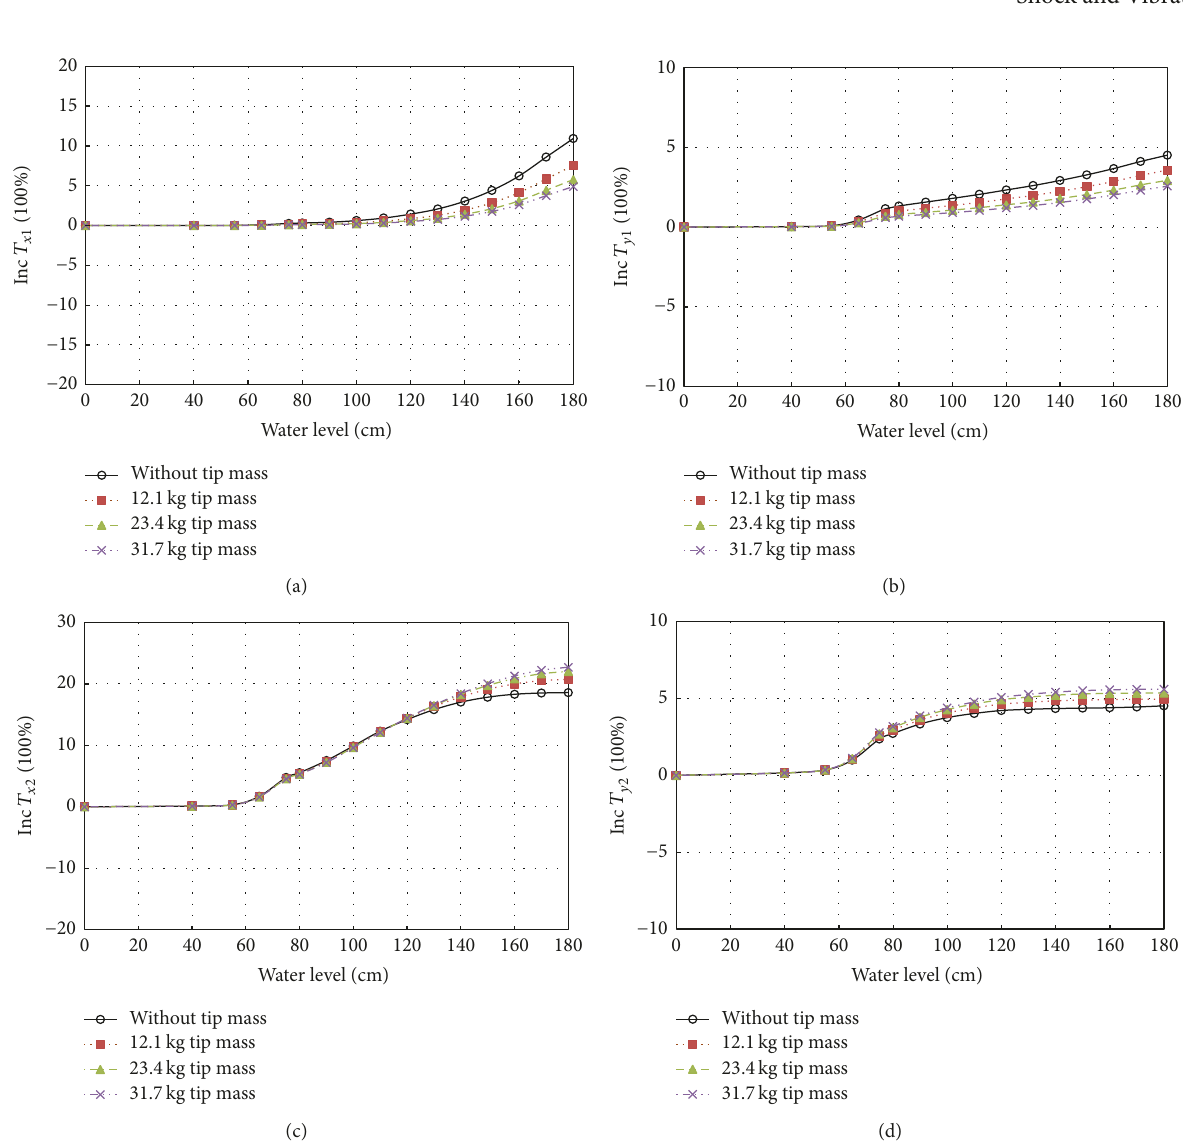
Figure 16: Computed period percentage increases for the pier specimen as a function of water level: (a) first mode along 𝑥 -axis; (b) first mode along 𝑦 -axis; (c) second mode along 𝑥 -axis; (d) second mode along 𝑦